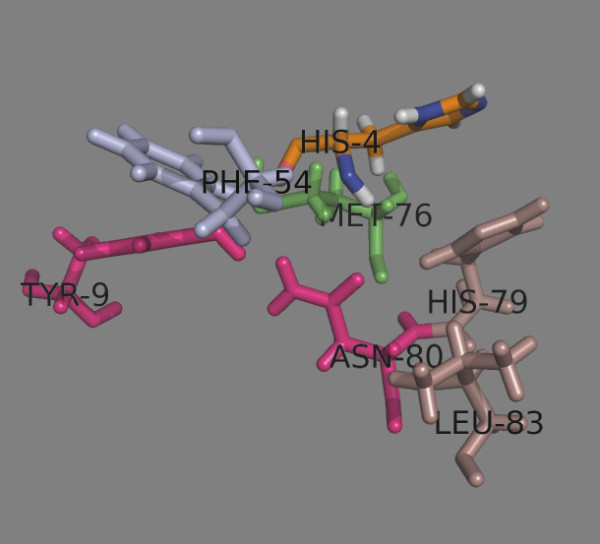
Peptide position 2. The α chain residues are shown in light blue, the β chain residues – in darksalmon. The dimorphic Met/Val76β is shown in green. Tyr9α and Asn80β (given in magenta) make H-bonds with p2 residue His (given as HIS-4 in orange).